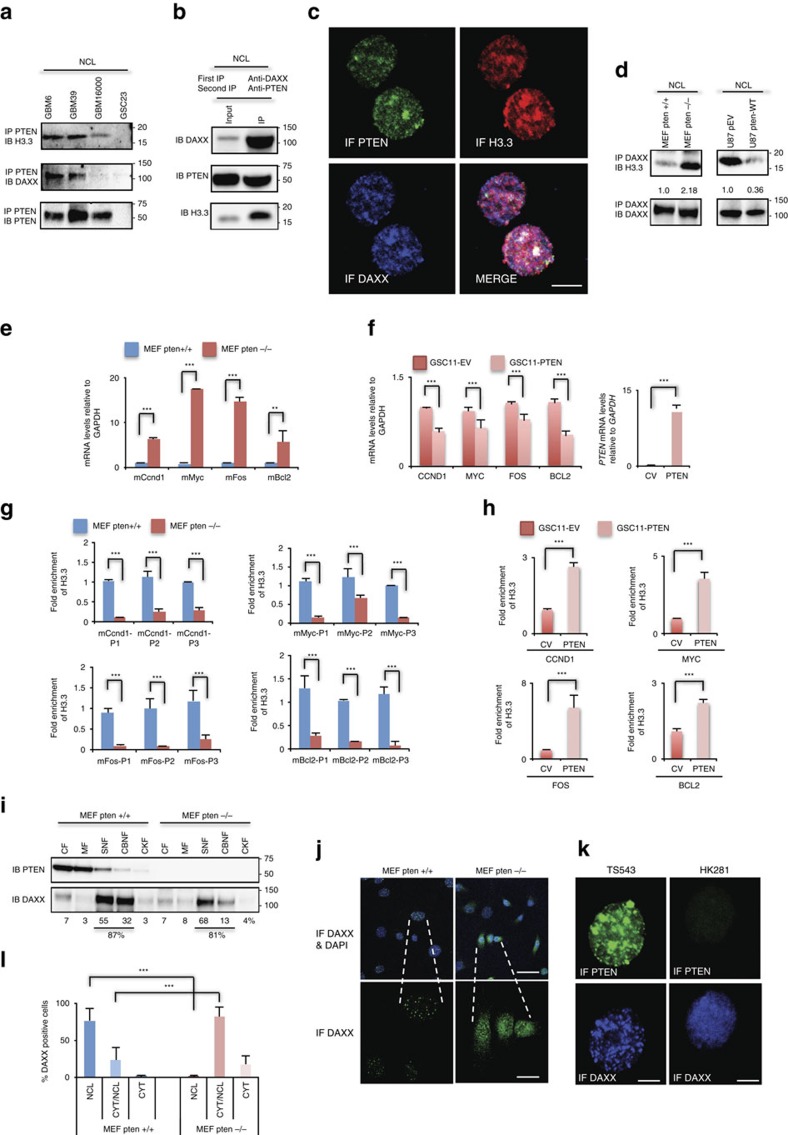
PTEN represses oncogene expression by controlling H3.3 deposition on chromatin and H3.3-DAXX interaction.(a) Co-immunoprecipitation analysis of anti-PTEN followed by anti-H3.3 or anti-DAXX immunoblotting were performed using nuclear protein (NCL) from patient-derived glioma spheres. (b) Sequential immunoprecipitation from nuclear extracts of HK281-PTEN GBM-spheres. First IP anti-DAXX and second IP anti-PTEN, and immunoblots anti-DAXX, anti-PTEN and anti-H3.3. (c) Confocal immunofluorescence analysis of endogenous PTEN, H3.3 and DAXX proteins in TS576 GBM-spheres (Pearson’s coefficient in colocalized region equal to 0.4168). Scale bar, 5 μm. (d) Nuclear proteins from MEF pten+/+ and MEF pten−/− (left), and U87 glioma cells (right) transfected with empty vector pEV or PTEN-WT were immunoprecipitated with anti-DAXX followed by immunoblotting with anti-H3.3. (e,f) mRNA expression analysis of CCND1, MYC, FOS and BCL2 by RT–qPCR in PTEN-WT or PTEN-deficient cells (n=3 biological samples with three replicates each, **P<0.001, ***P<0.0001, one-way ANOVA). (g,h) ChIP-qPCR of H3.3 in PTEN-WT or PTEN-deficient cell, using different sets of primers that anneal within 1–2 Kb of the transcription start site. For ChIP assays, bar graphs indicate fold enrichment of H3.3 over input (n=3 biological samples with three replicates each, ***P<0.0001, one-way ANOVA). (i) Cellular fractionation was carried out in MEF cells followed by anti-DAXX and anti-PTEN immunoblotting. DAXX expression was quantified by densitometry analysis. (j,k) Representative immunofluorescence images of endogenous DAXX expression in MEFs (j) or GBM-spheres (k). For j top scale bar is 20 μm and bottom scale bar is 50 μm. For k scale bar is 5 μm. (l) Percentage of DAXX-positive cells in different cellular compartments in Pten-wt and Pten-null MEFs. NCL: nuclear; CYT/NCL: cytosolic and nuclear; CYT: cytosolic; NS: no significant differences. Error bars represent s.e.m. from three different experiments, ***P<0.0001, one-way ANOVA.